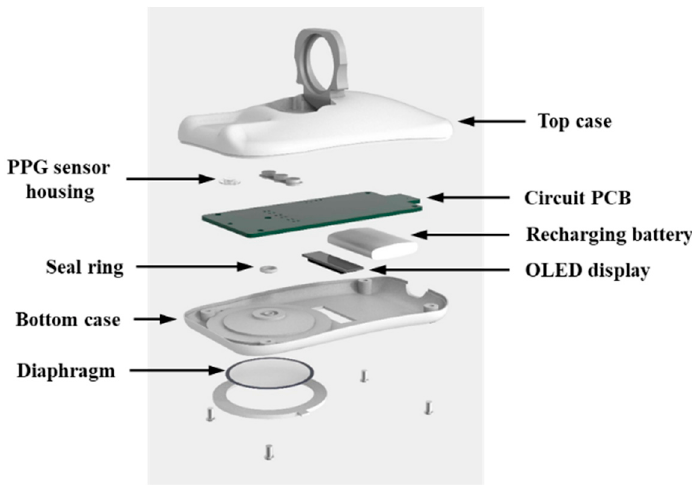
Figure 3. Structure of the proposed multimodal smart stethoscope in